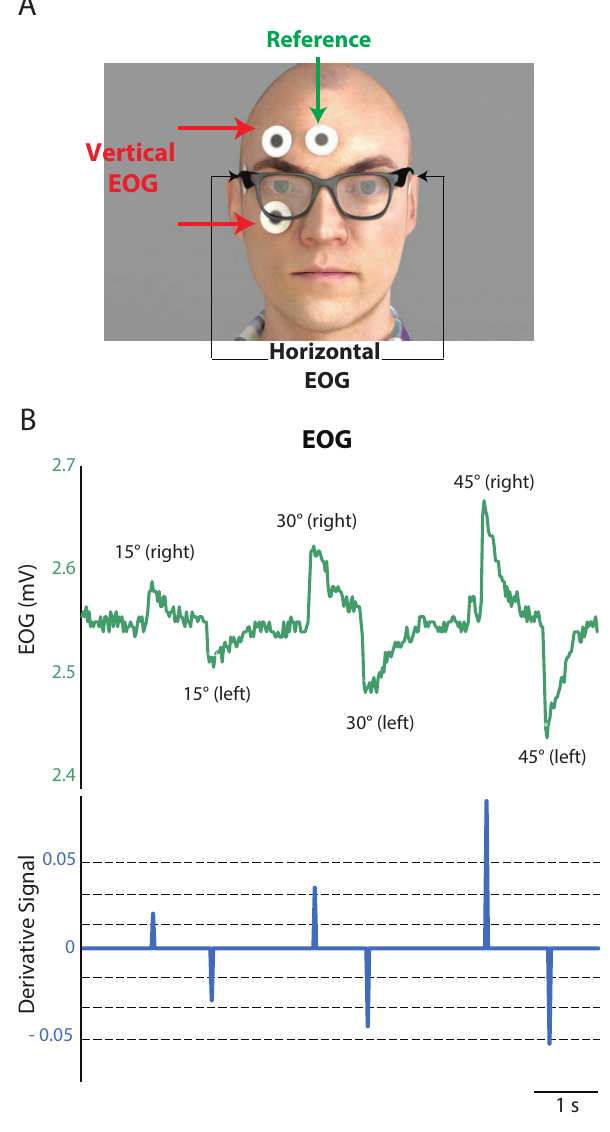
Figure 2. ( A ) EOG and reference electrode placement; ( B ) Example raw EOG signal ( top ) and the extracted eye movement signal with differentiation and thresholding ( bottom